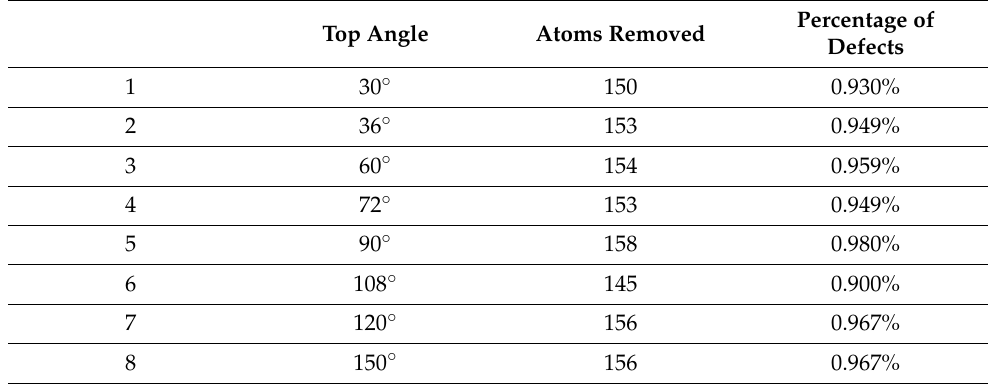
Table 1. The setup of the eight models. The number of atoms removed and their percentage out of the total number of atoms in the system, as summarized according to the top angle. We aim to use the same area of the triangle for comparison. Percentage of Top Angle Atoms Removed Defects 30 ◦